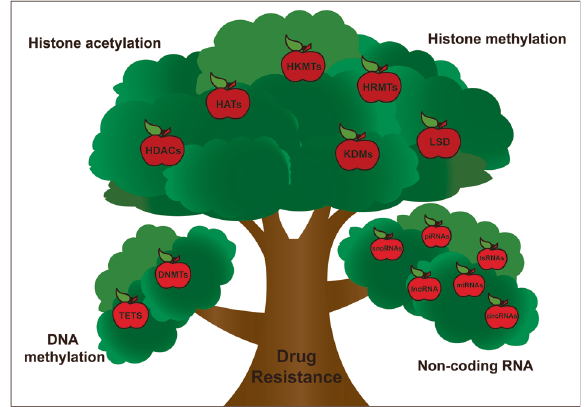
Fig. 2 Epigenetic regulation mechanisms of drug resistance. Non- coding RNAs, DNA methylation, and histone modi fi cations including histone acetylation and methylation play important roles in tumor resistance. DNA methylation is maintained by DNA methyltrans- ferases and DNA demethylases, histone acetylation is regulated by histone acetyltransferases and histone deacetylases, and histone methylation is maintained by histone demethylases and histone